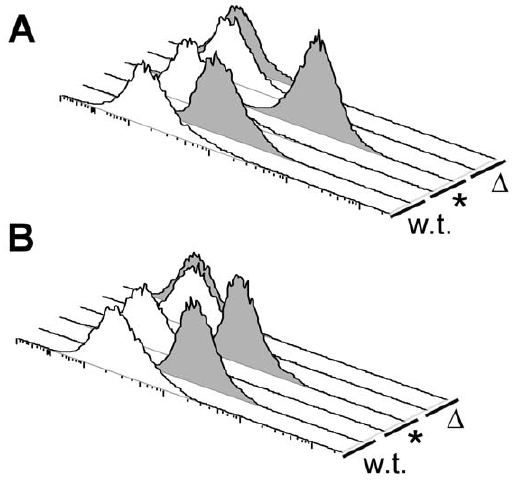
Figure 6. Specific antibodies recognize SpyCEP on bacteria. Exponential ( A ) and stationary ( B ) phase bacteria were labeled with pooled mouse a -Alum (white) or mouse a -SpyCEP (gray) sera. Secondary antibodies were rabbit a -mouse phycoerythrin conjugates, and the fluorescence (PE-A) is shown on the x axis. Strains 3348 (w.t.), 3348 D spyCEP ( D ) and 3348 spyCEP * (*) are displayed on the z